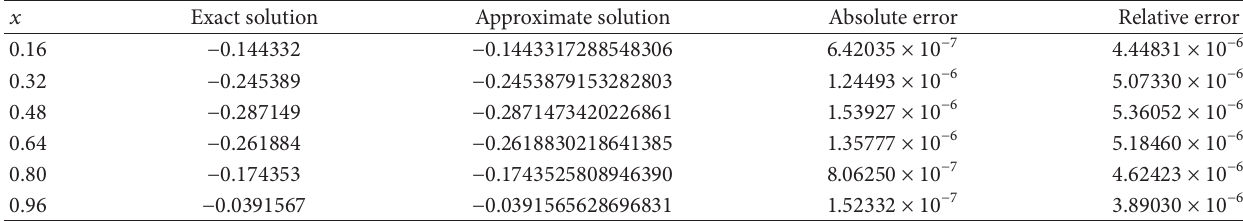
Table 6: Numerical results of 𝑢 1 (𝑥) for Example